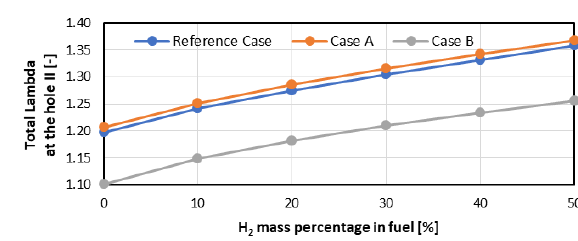
Fig. 14. Air-fuel equivalence ratios located after second liner hole